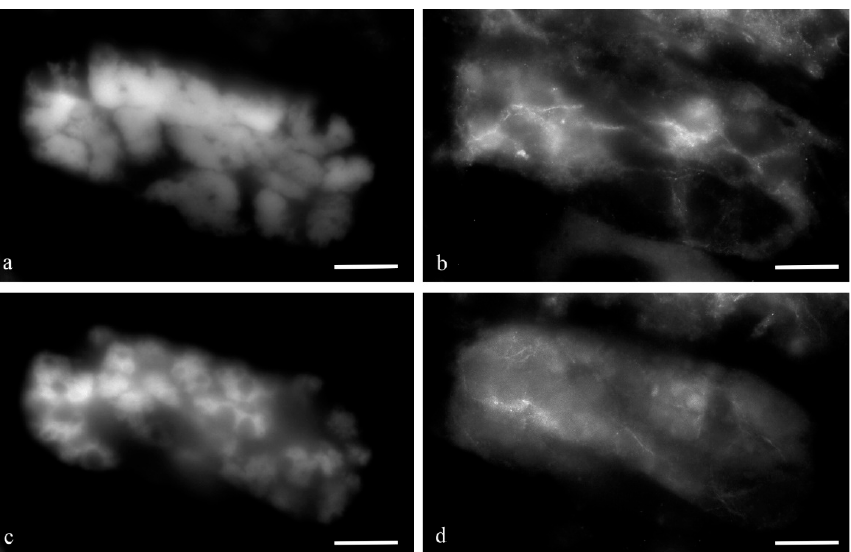
Figure 13. Bundles of microtubules of the cytoskeleton of the cytoplasm of the antipodal cells of the wheat embryo sac at the middle stage of programmed cell death. The structure of the chromosomes of the nucleus of the antipodal cell is represented in two optical slices ( a , c , DAPI). Rare, fragmented bundles of microtubules are concentrated in the cytoplasm with the invaginations of the nuclear envelope around polytene chromosomes ( b , d , DM1a).